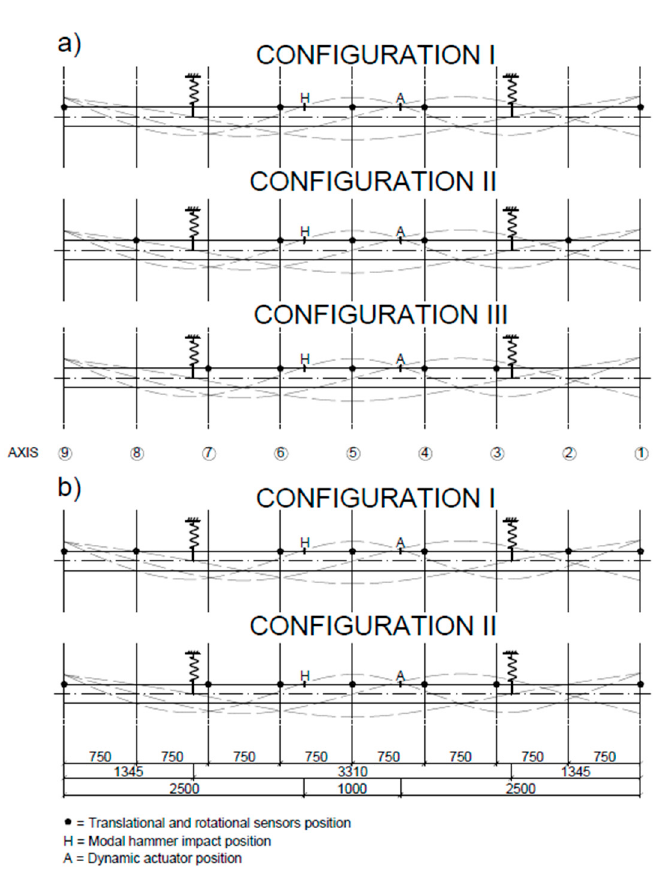
Figure 5. Sensors configuration for ( a ) beam UHPC1_L and ( b ) beam UHPC2_L. Dashed lines show the theoretical mode shapes computed for the Euler–Bernoulli beam.